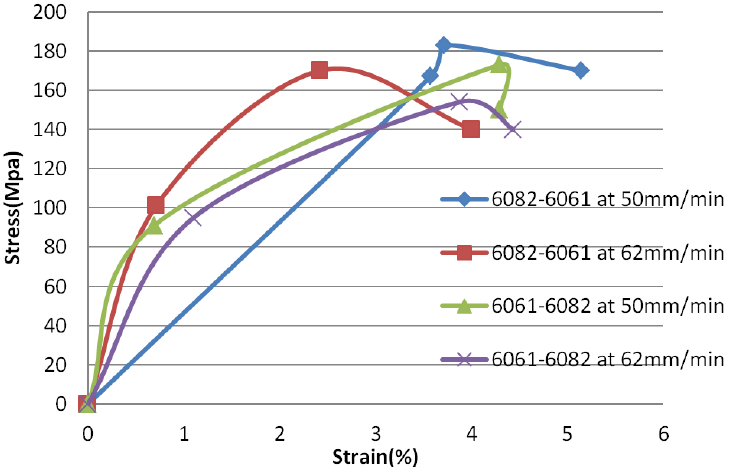
Figure 3: Stress-Strain curves for dissimilar alloys AA6082-AA6061.